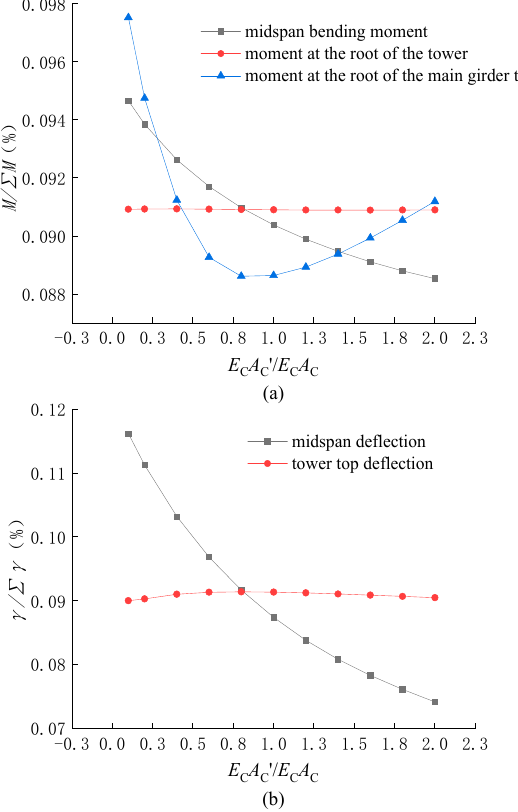
Figure 5. Effects of cable stiffness on structural internal forces and deformation. ( a ) moment; Figure 5. E ff ects of cable sti ff ness on structural internal forces and deformation. ( a ) moment ; ( b ) ( b ) de fl ection.